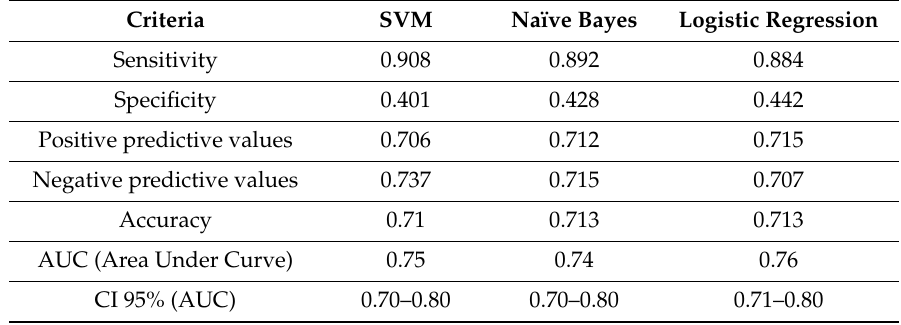
Table 3. Comparing the